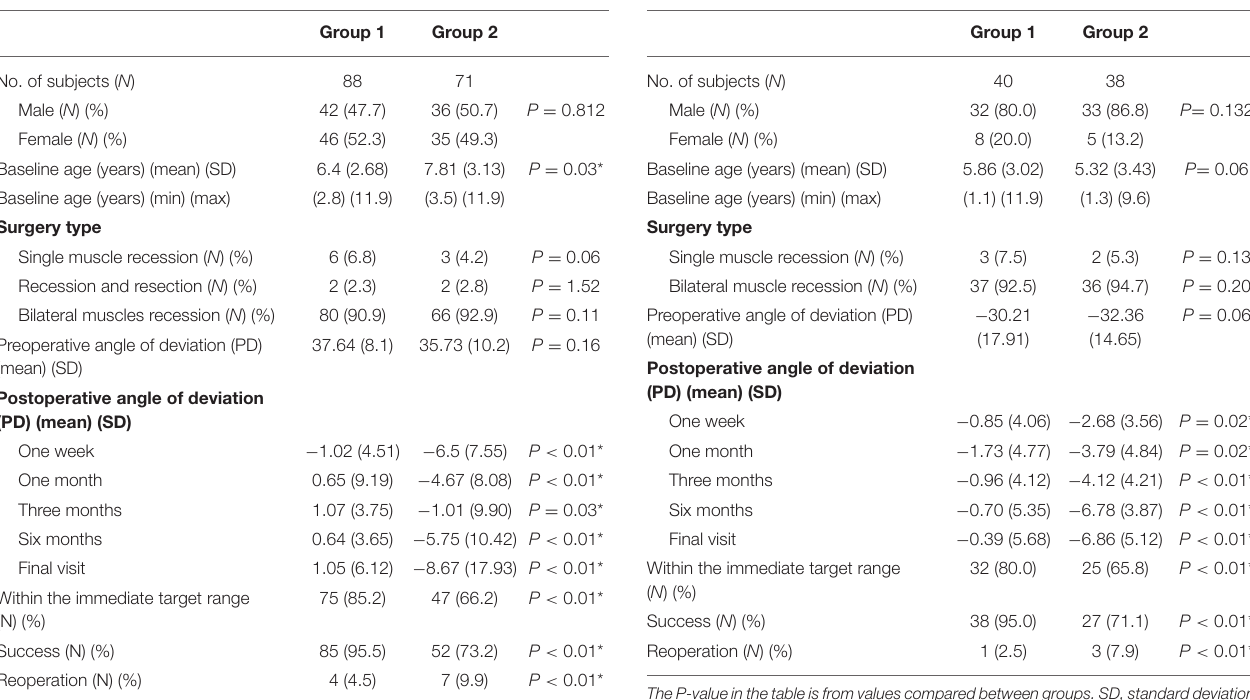
TABLE 2 | Detailed information on exotropic patients. TABLE 3 | Detailed information on esotropic